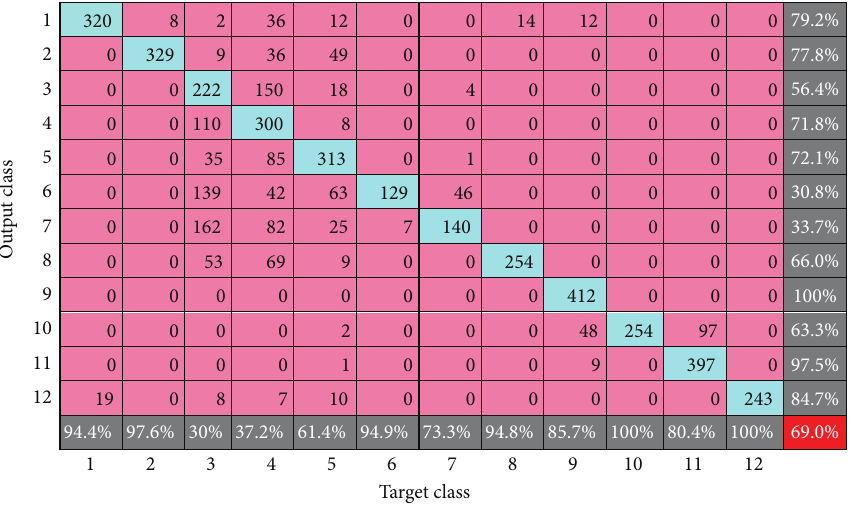
Table 8: Comparisons of classification rate with SVM using 20 test cases.